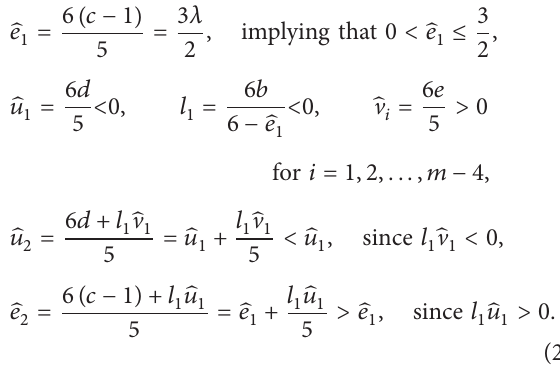
Figure 2: Computational molecule of the IADEMF4 at the (𝑝+1/2) iteration level.